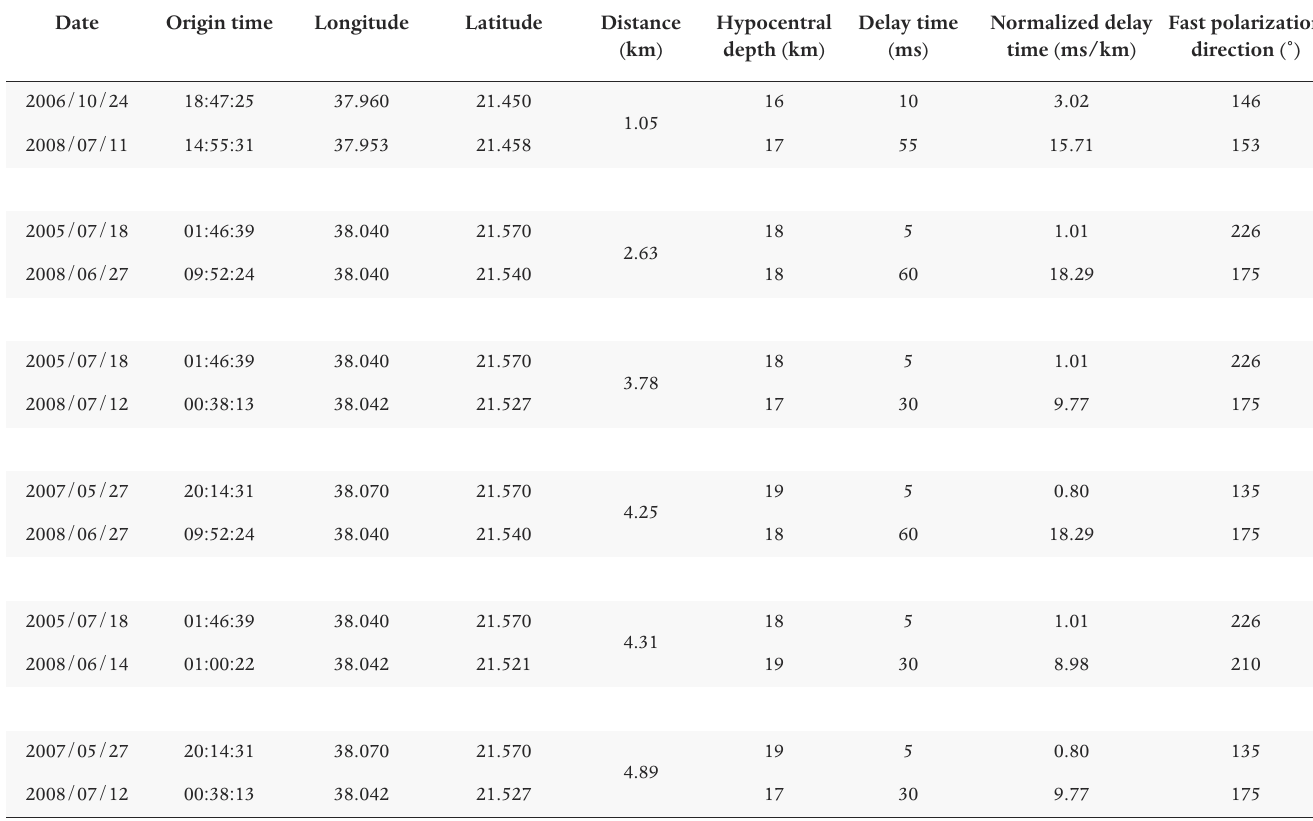
Table 1. Location and splitting parameters for the selected pairs of events with nearby locations, before and after the Movri Mountain earthquake (June 8, 2008). Time-delays are normalized to a 1-km path